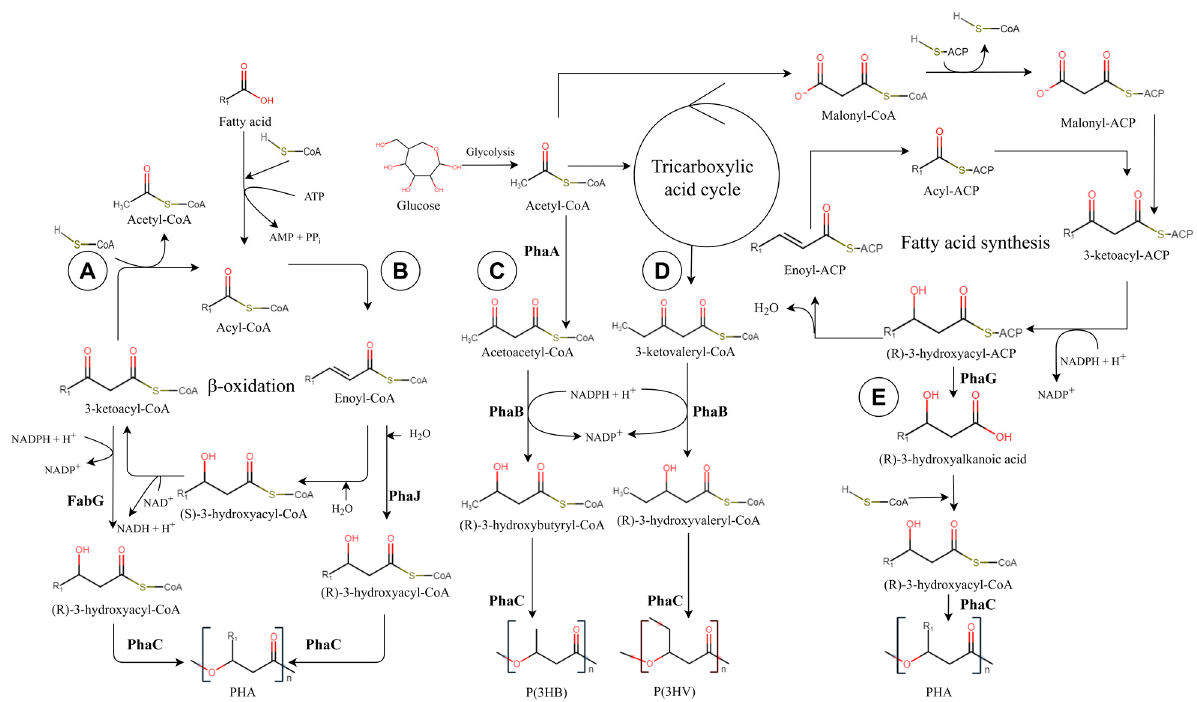
Figure 1. PHA biosynthetic pathways: ( A , B ) Production of PHAs from related carbon sources via β‐oxidation; ( C , D ) production of scl PHAs from unrelated carbon sources; ( E ) production of mcl PHAs via fatty acid synthesis. (FabG: 3 ‐ ketoacyl reductase; PhaA: 3 ‐ ketothialase; PhaB: NADPH acetoacetyl ‐ CoA reductase; PhaC: PHA synthase; PhaG: hydroxyacyl ‐ ACP specific thioesterase; PhaJ: R ‐ specific enoyl hydratase; PHA: polyhydroxyalkanoate; P(3HB): poly(3 ‐ hydroxybutyrate); and P(3HV): poly(3 ‐ hydroxyvalerate).) (Adapted from [14–18].)